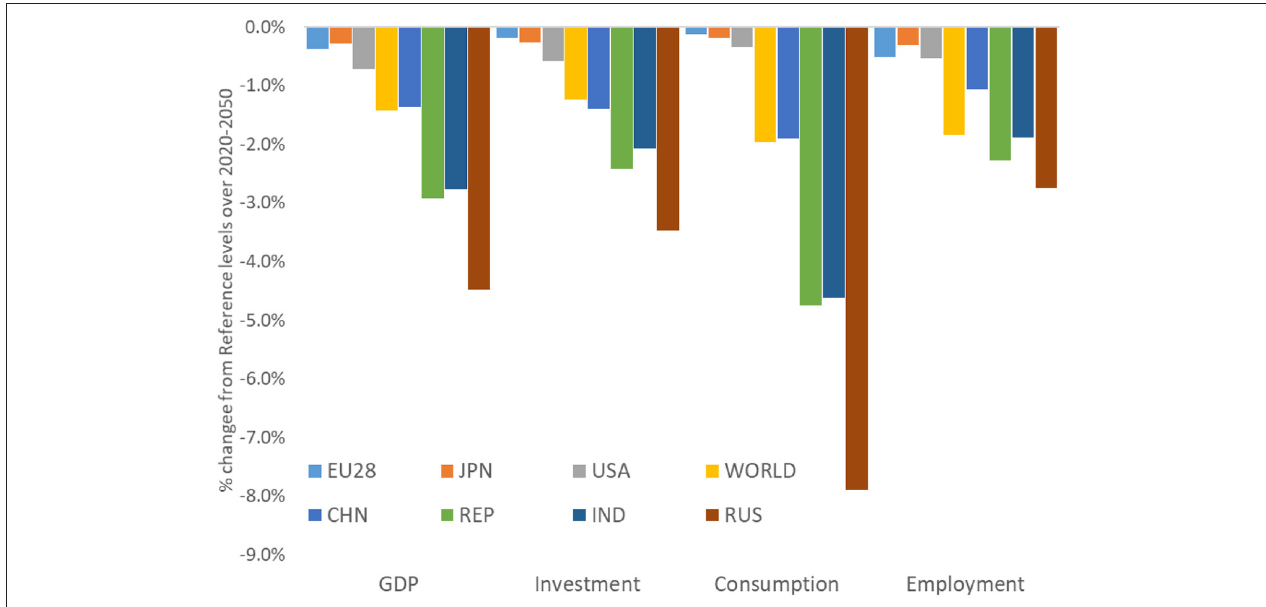
FIGURE 13 | Macro-economic impacts of the 2DEG scenario in major